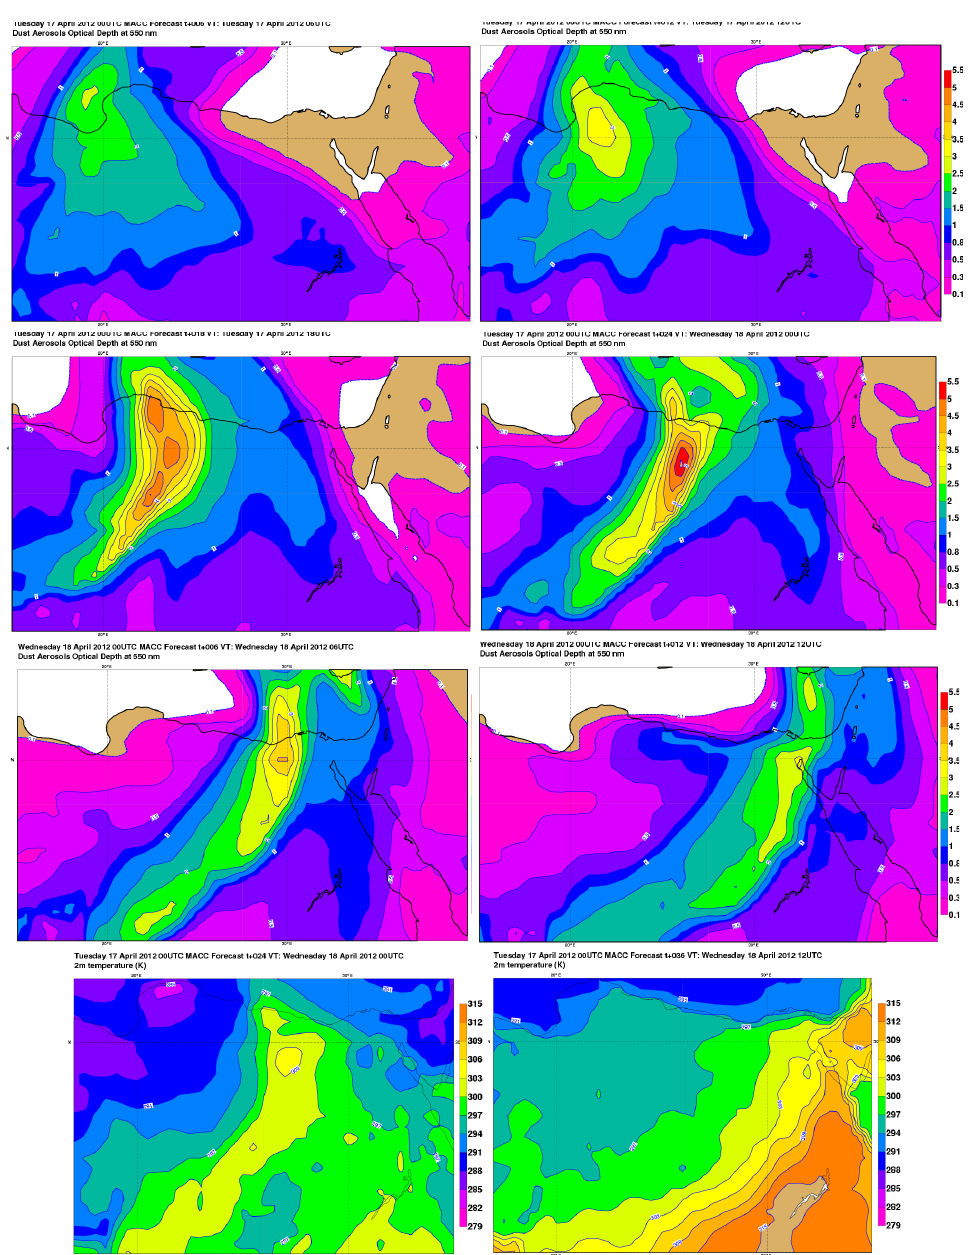
Figure 4. AOD at 550nm from 17 April 2012, 06:00UTC (top left), to 18 April, 12:00UTC (middle bottom right); REF experiment starting on 17 April 2012, 00:00UTC, and 18 April 2012, 00:00UTC. At the bottom: simulation starting on 17 April 2012, REF experiment for 2m temperature; 24h forecast time (left), 36h forecast time